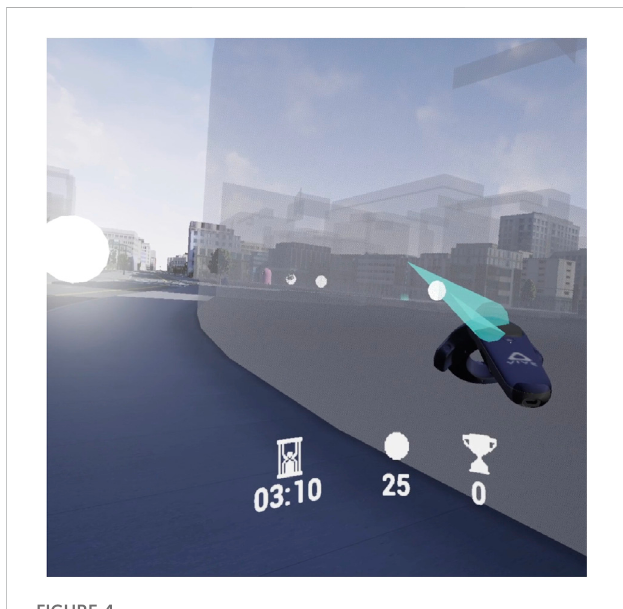
FIGURE 4 A screenshot of the implemented X-Ray Vision technique.